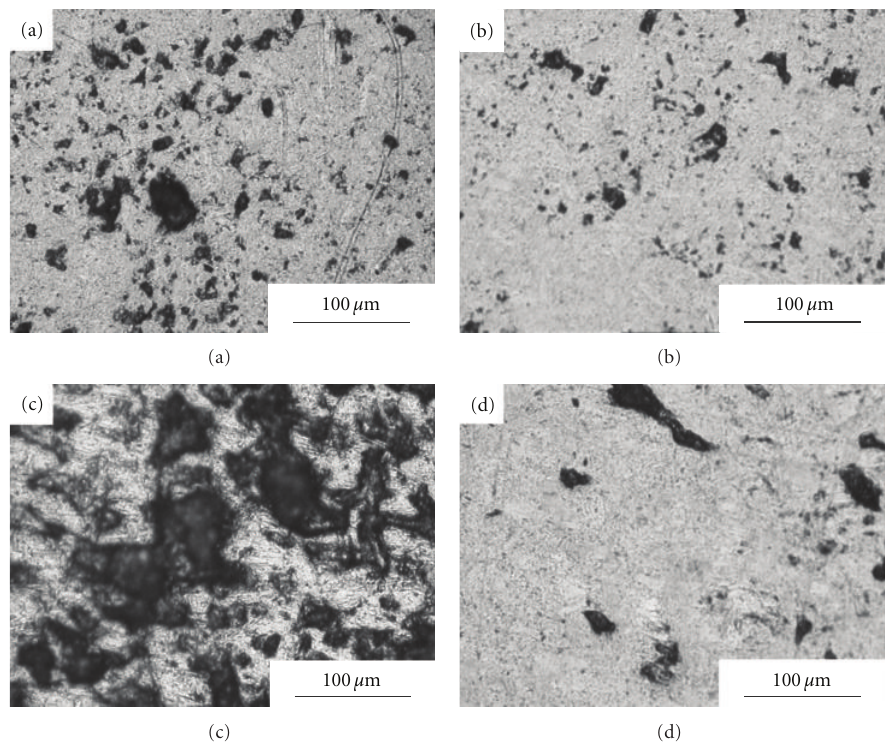
Figure 3: Graphite morphology before irradiation. (a) Porous region; (b) few pores region in IG-11; (c) porous region; (d) few pores region in HSM-SC.